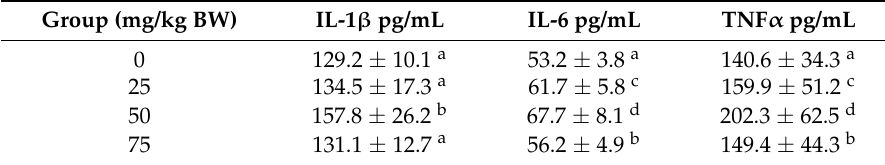
Table 6. Effect of oral administration with the SCP on lipopolysaccharide (LPS)-induced cytokines production by lymphocyte of C57BL/6 mice.